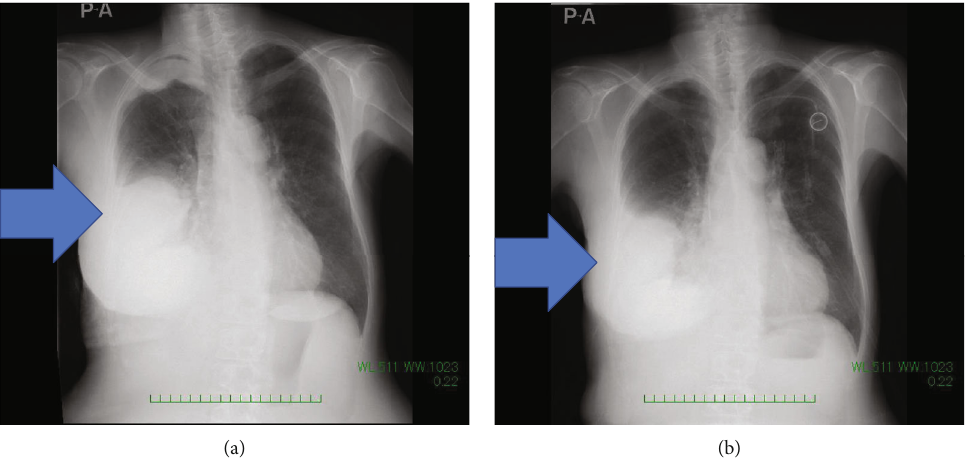
Figure 2: (a) CXR before dabrafenib and trametinib initiation. (b) 1 week after treatment. Arrow shows pleural e ff usion.